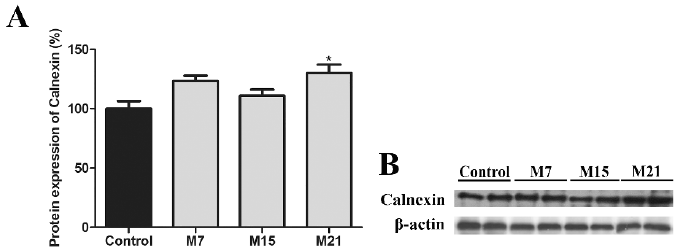
Figure 5 . Protein expression of ER marker calnexin in rat brown adipose tissue of the euthyroid control (black) and hypothyroid groups (grey) treated with methimazole for 7 (M7), 15 (M15), and 21 (M21) days, respectively ( A ). The protein content is expressed as a percentage of the control. Band images from a representative blot of three trials are shown ( B ). Bars represent the mean ± SEM. * Compared to control, * p < 0.05.